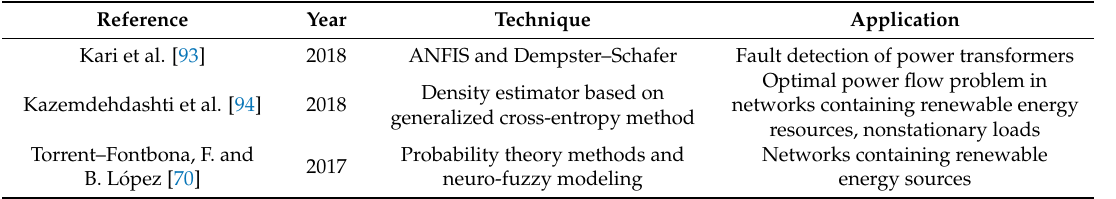
Table 9. Application of probabilistic reasoning in the field of electrical machines and power